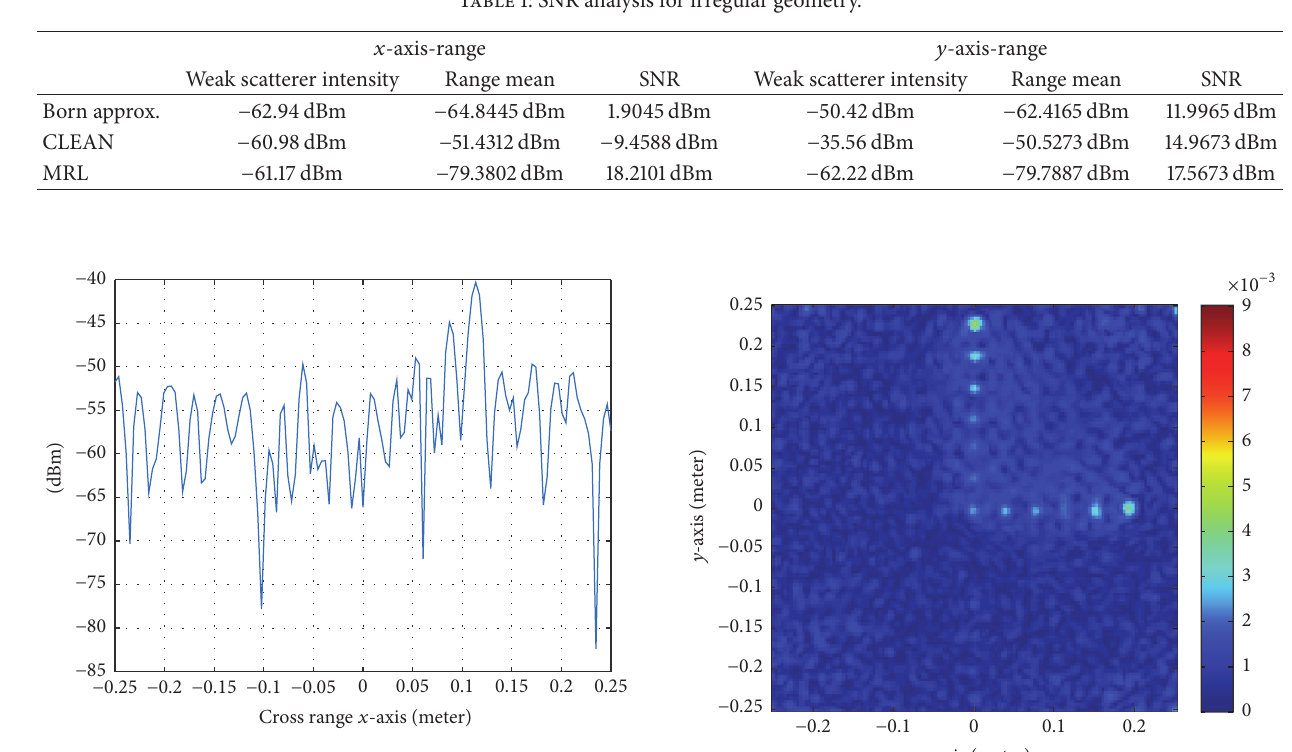
Figure 18: The sectional view of power density and sidelobe at 𝑥 - axis after applying CLEAN algorithm for irregular complex target shape geometry.